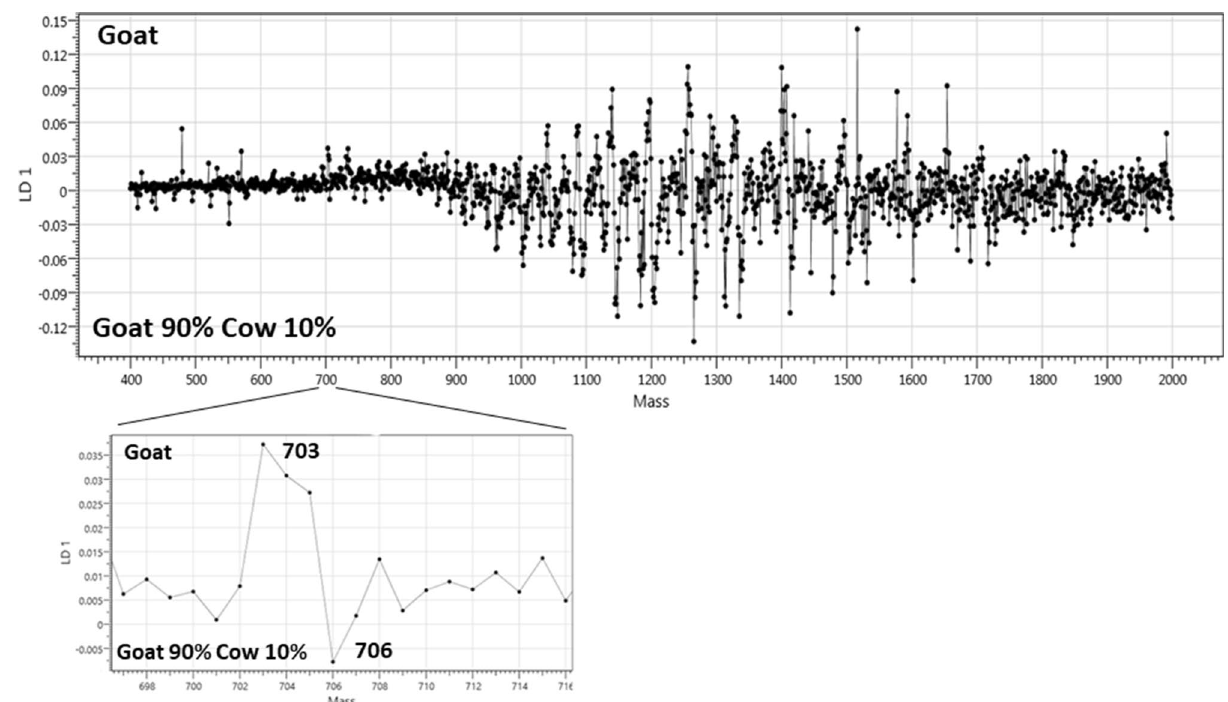
Figure 4. Loading plot of the Linear Discriminant Analysis (LDA) for separating pure goat milk and goat milk adulterated with 10% cow